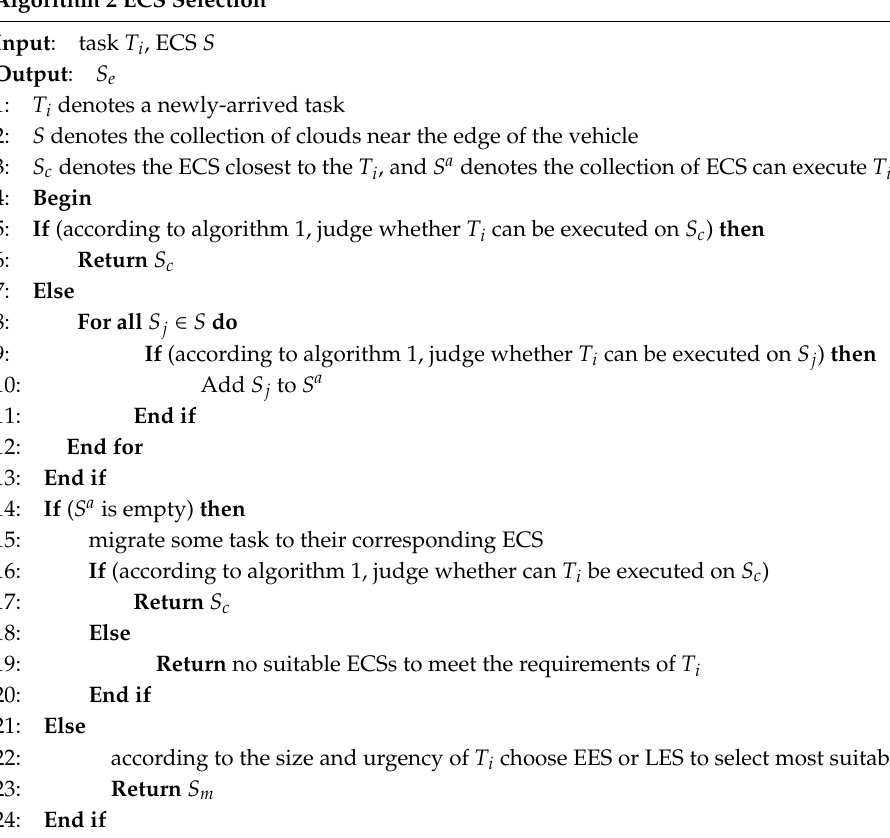
Algorithm 2 ECS